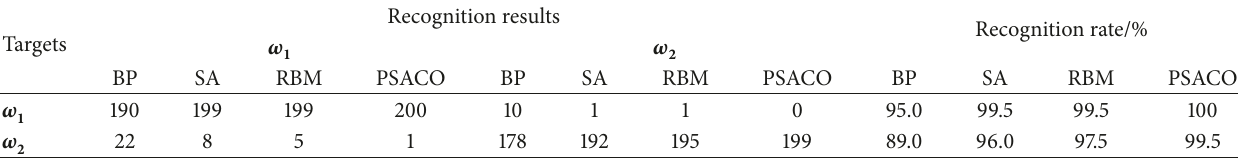
Table 10: Recognition results of CNIS-I for transformed sample.